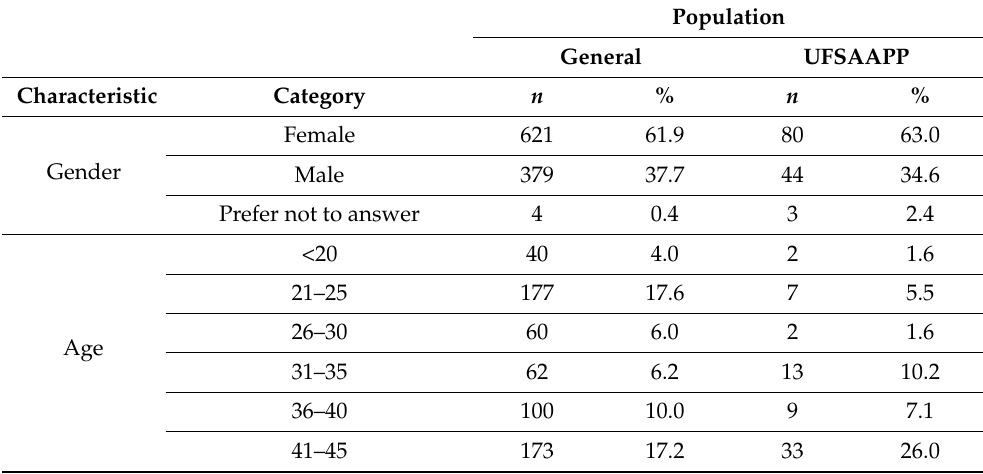
Table 2. Sociodemographic characterisation of the respondents, where n is the number of individuals in each